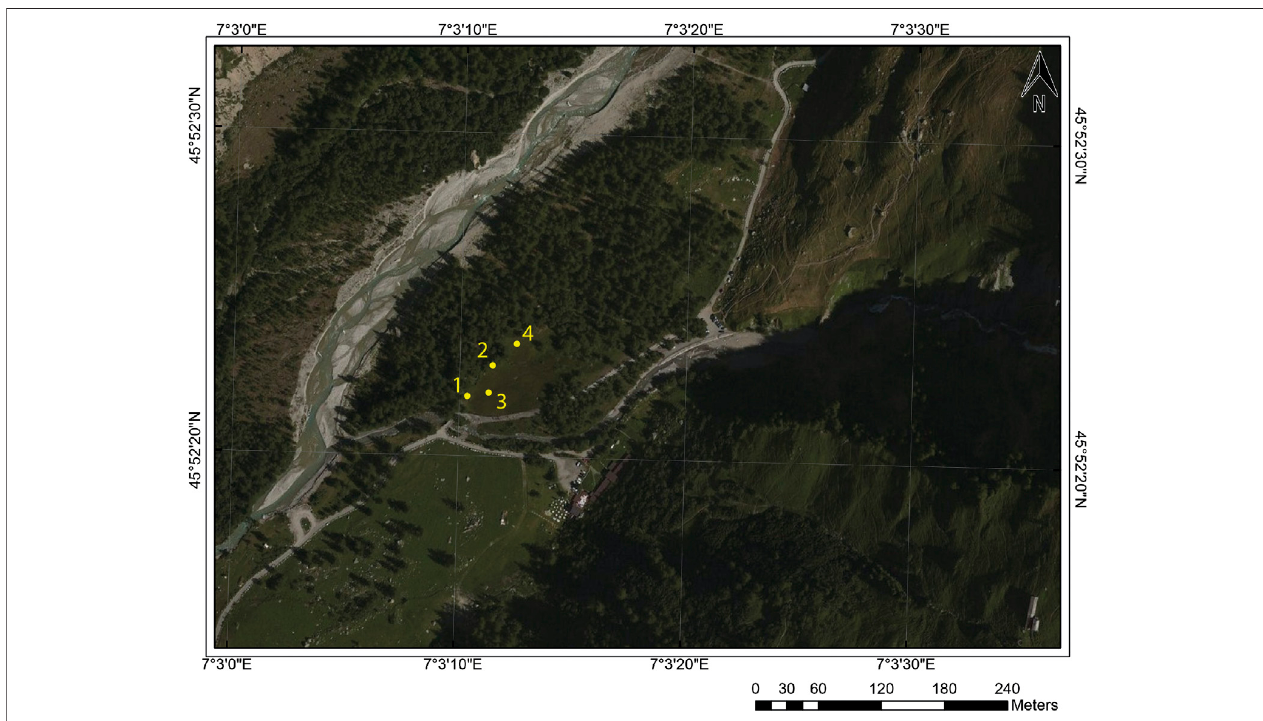
FIGURE 3 | Sample location of the four pits (Arp Nouva). A boulder was found at the bottom of the pit Arp Nouva -3. The woods around the pits constitutes of larch trees.